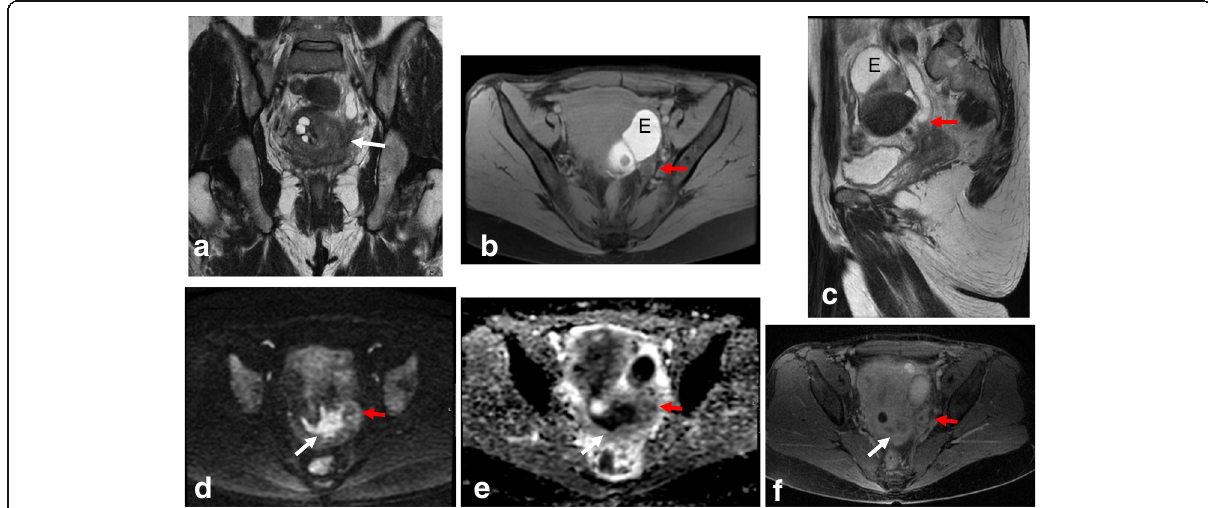
Fig. 16 MRI reveals FIGO IIIB cervical cancer in a 38-year-old woman with adenomyosis and endometriosis in the left ovary. Visualization by coronal T2WI ( a ), axial FS T1WI ( b ), and sagittal T2WI ( c ) reveals a mass extending to the left parametrium and involving the left ureter (red arrows) below the endometrioma (E), with a subsequent hydronephrosis. d , e DWI ( b = 1000/ADC map) reveals diffusion restriction of the cervical mass, with extension to the left ureter. f DCE sequence shows enhancement of the cervical mass and ureter